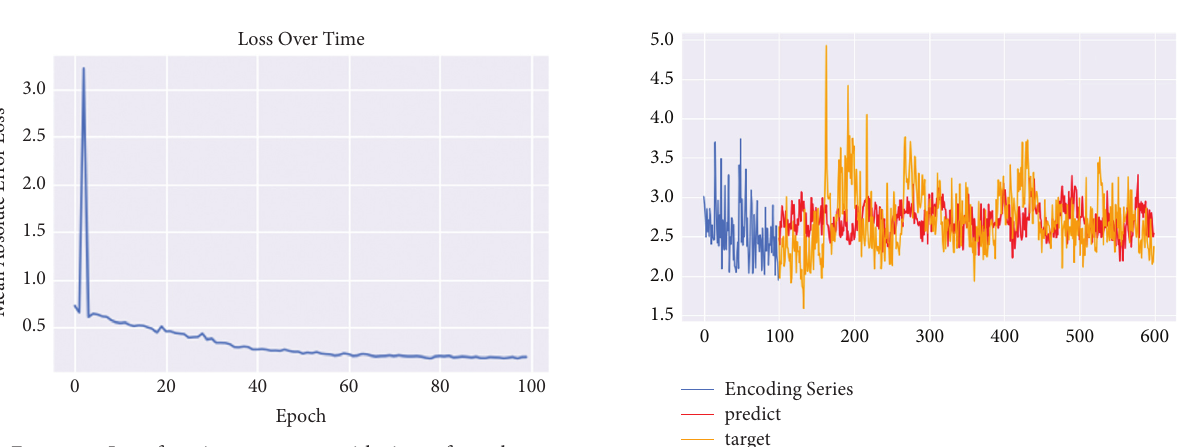
Figure 7: Loss function converges with time of epochs.